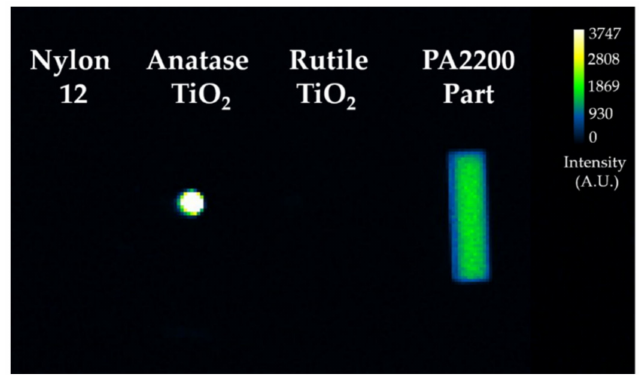
Figure 1. Photoluminescent signal of PA2200 and related components.